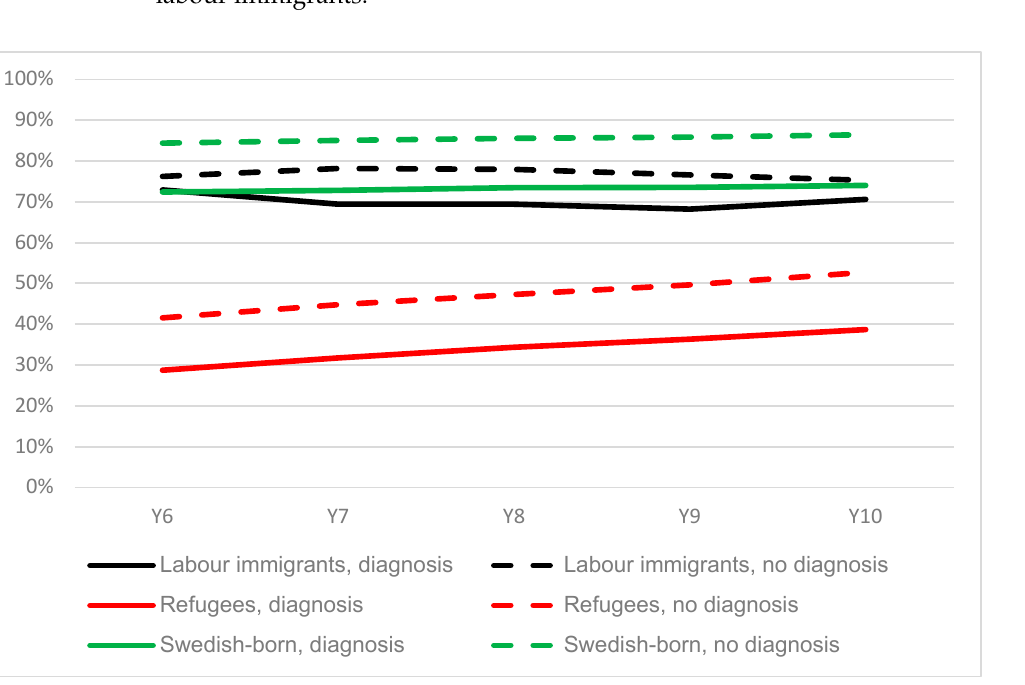
Figure 4. The proportion of labour immigrants, refugees and Swedish-born with or without a diagnosis from hospitalisation or specialised outpatient care 1 at years 1–5 with an income of 1.75 PBA or more from paid work during years 6–10 ( n = 169,863). 1 Diagnosis from ICD-10: F31–F38,